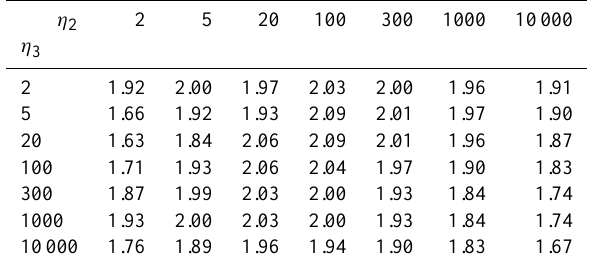
Table A5. Tangent of the slope of the curve showing the dependence of the logarithm of L 2 -error for velocity component v x on the loga- rithm of the grid step for different viscosity contrasts. Exponentially varying viscosity.